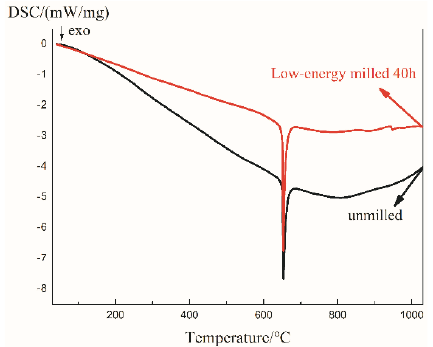
Figure 3. DSC curve of Ti-7Al-0.2B un-milled and low-energy ball milled powders.